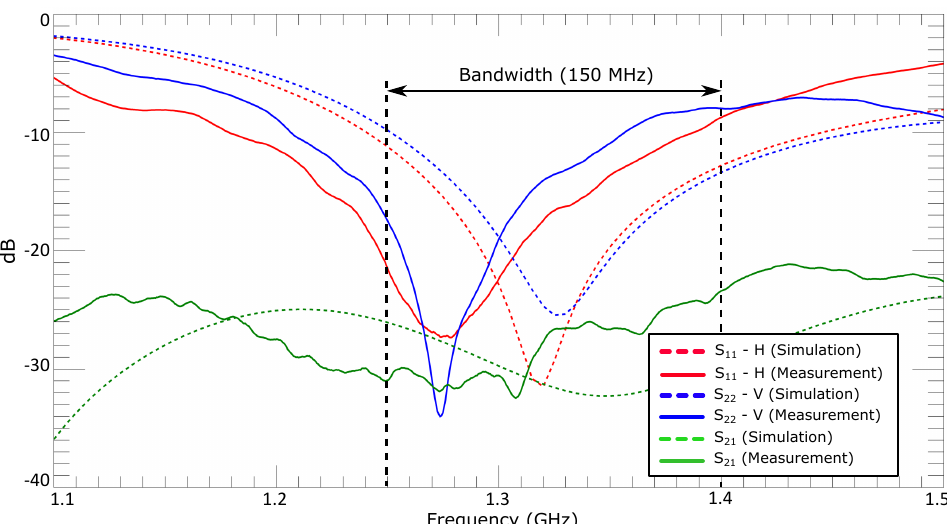
Figure 4. Simulated and measured